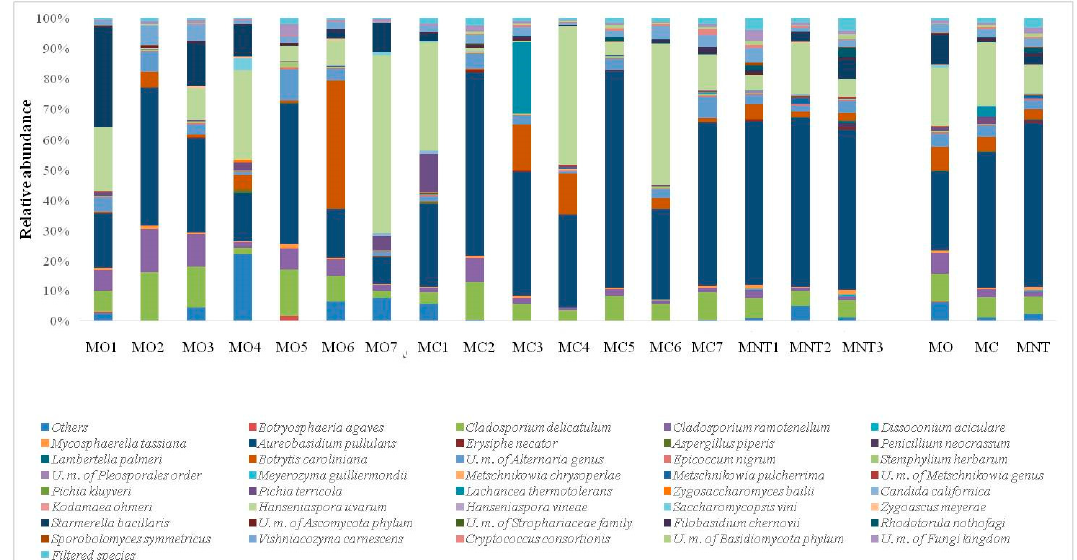
Figure 2. Relative abundance of grape fungal community detected by next generation sequencing (NGS) at harvest time in organic (MO), conventional (MC) and not treated (MNT) samples. The number associated to the samples represent the replicates for each treatment. In the microorganisms legend, U.m. abbreviation means undefined microorganism. Only the taxa > 0.5% are shown and the taxa ≤ 0.5% are grouped under the heading Filtered species of the legend. To the right of the graph, mean values of each treatment are represented (MO, MC and MNT).